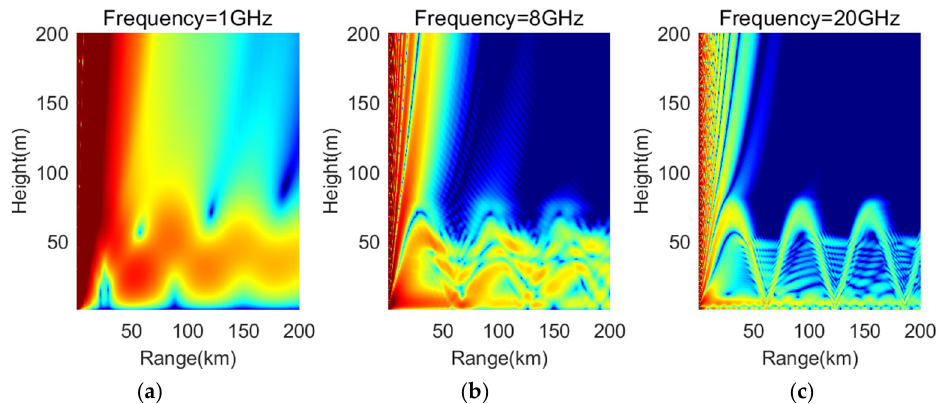
Figure 13. Path loss distributions for evaporation ducts with different frequencies: ( a ) frequency of 1 GHz, ( b ) frequency of 8 GHz, and ( c ) frequency of 20 GHz.